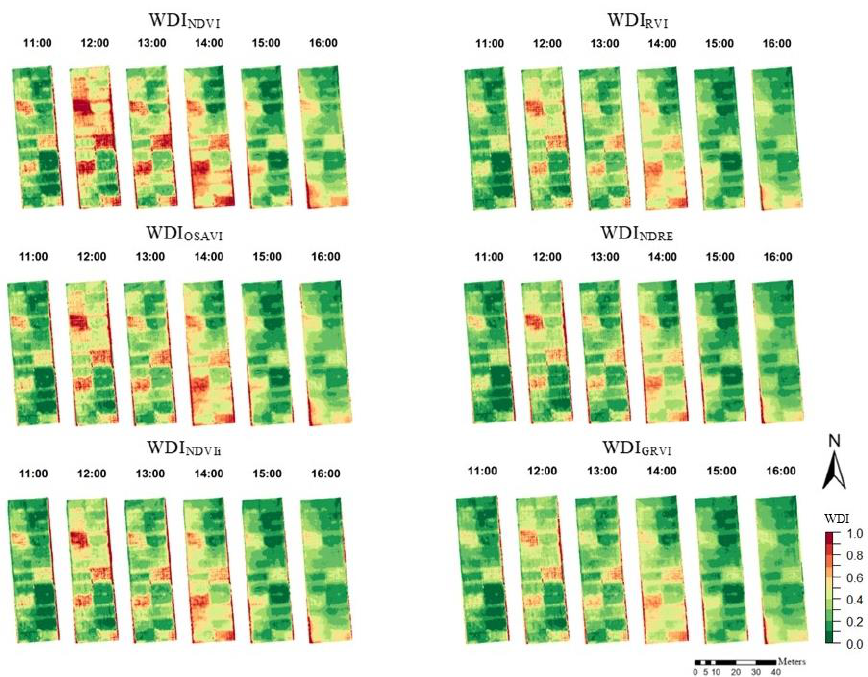
Figure A2. WDI maps calculated from different multispectral indices for the diurnal winter wheat flights on 23 April 2020.